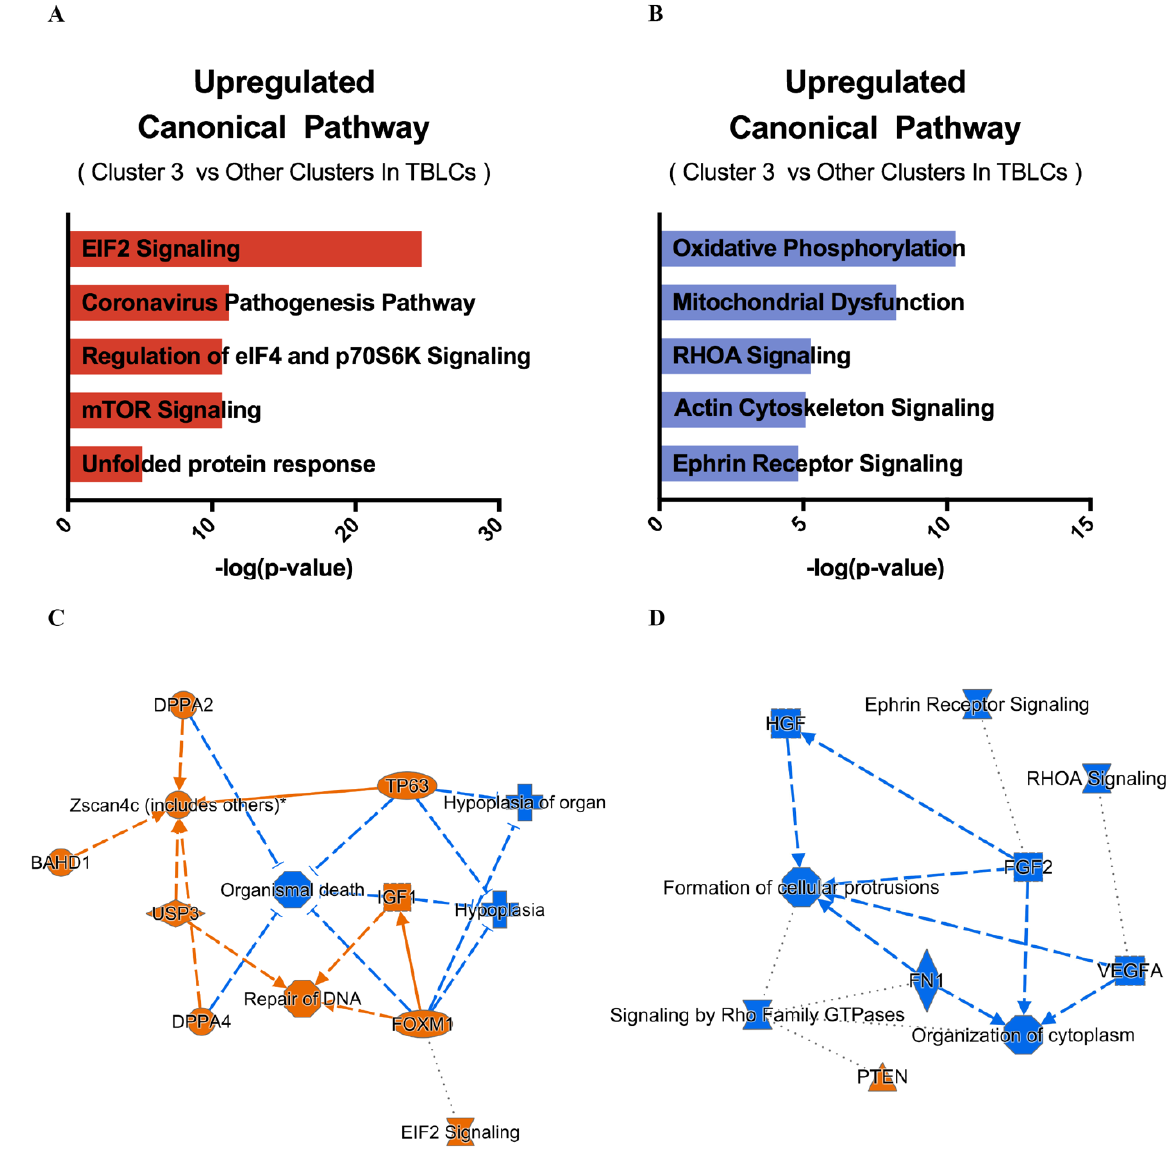
Figure 9. Gene ontology and pathway analyses of cluster 3 differentially expressed genes. ( A ) The top 5 canonical pathways were derived from the ingenuity pathway analysis (IPA) gene ontology of cluster 3 gene markers. ( B ) The top 5 canonical pathways were derived from the IPA gene ontology of cluster 3 downregulated genes. ( C ) Graphical summary of predicted pathway regulation of cluster 3 gene markers. ( D ) Graphical summary of predicted pathway regulation for cluster 3 downregulated genes. Orange lines indicate upregulation while blue lines indicate downregulation.